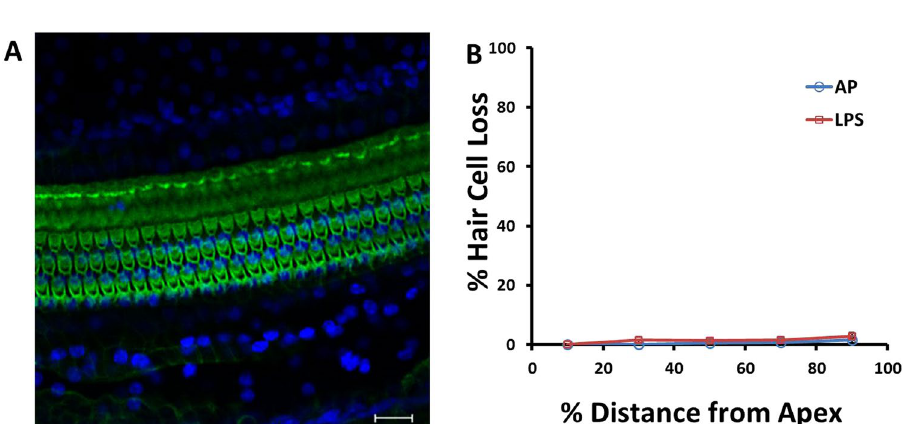
Figure 4. Effect of LPS on hair cells. ( A ) Example of hair cell stereocilia labeling in the LPS group. FITC- conjugated phalloidin (green) and DAPI (blue) were used to label stereocilia and nuclei, respectively. No hair cell loss was observed in the organ of Corti. Scale bar = 20 μ m. ( B ) No significant hair cell loss in the LPS group compared to the AP